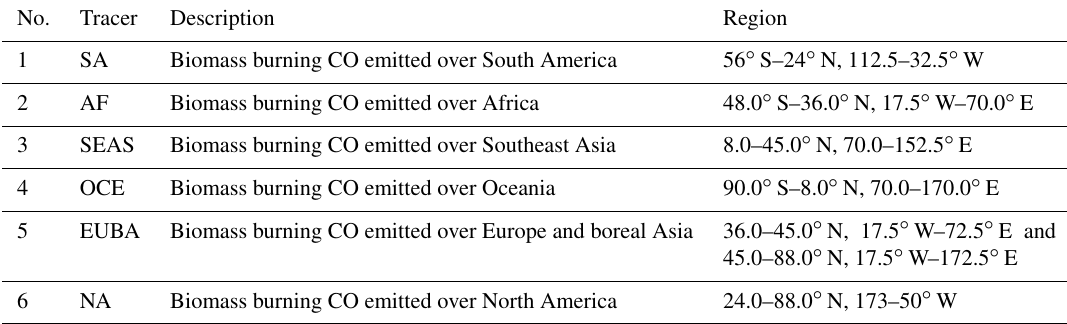
Table 3. Regional definitions of all biomass burning tracers implemented in the standard GEOS-Chem tagged CO simulation.